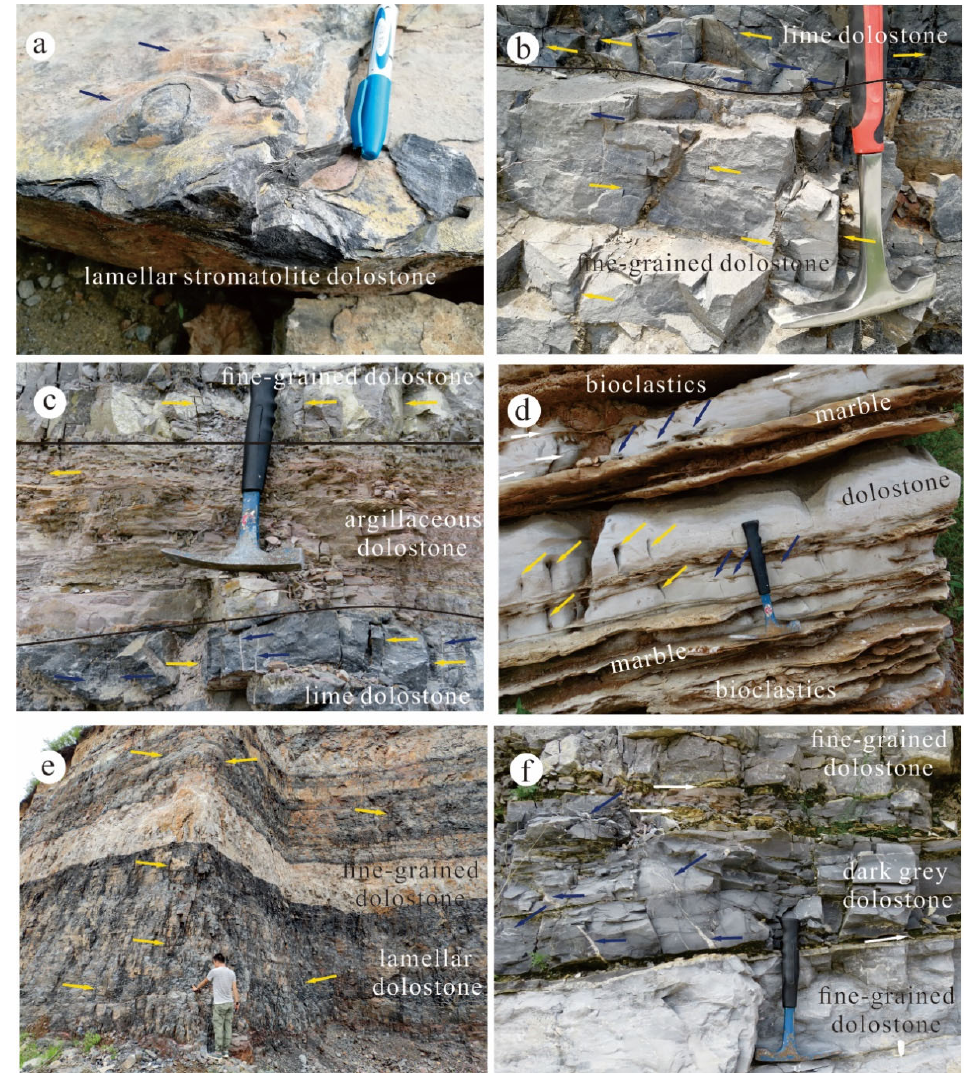
Figure 3. Field photos of the carbonate rocks from the Gaoyuzhuang ( a – c ) and Wumishan Formations ( d – f ). ( a ) Finely laminated early diagenetic dolostone showing columnar stromatolites (blue arrows). The length of the pen is 14 cm. ( b ) Lime dolostone from the upper part and fine ‐ grained dolostone from the lower part showing numerous small calcite veins (blue arrows) and vertical joints (yellow arrows). The width of the hammer is 17 cm. ( c ) The fine ‐ grained dolostone in the upper part is gray ‐ white and has partial marbleization. Argillaceous dolostone in the middle part showing laminated and cracked structures. The lime dolostone from the lower part is dark gray and contains small calcite veins (blue arrows). Vertical joints (yellow arrows) are common in different types of dolostone. Rock occurrence is 165° ∠ 14°. The length of the hammer is 29 cm. ( d ) Marbleized dolostone showing bedding features (white arrows), chert nodules (blue arrows), and karrens (yellow arrows) and interbedding with laminated marble and bioclastics. The length of the hammer is 29 cm. ( e ) Interbedded fine ‐ grained dolostone and lamellar dolostone showing obviously different colors and cracked structures and containing vertical joints (yellow arrows). The height of the boy is 175 cm. ( f ) Dark gray dolostone showing numerous irregular calcite veins (blue arrows). Argillaceous clastics (white arrows) showing laminated structures and paralleling to stratification plane. The length of the hammer is 29 cm.